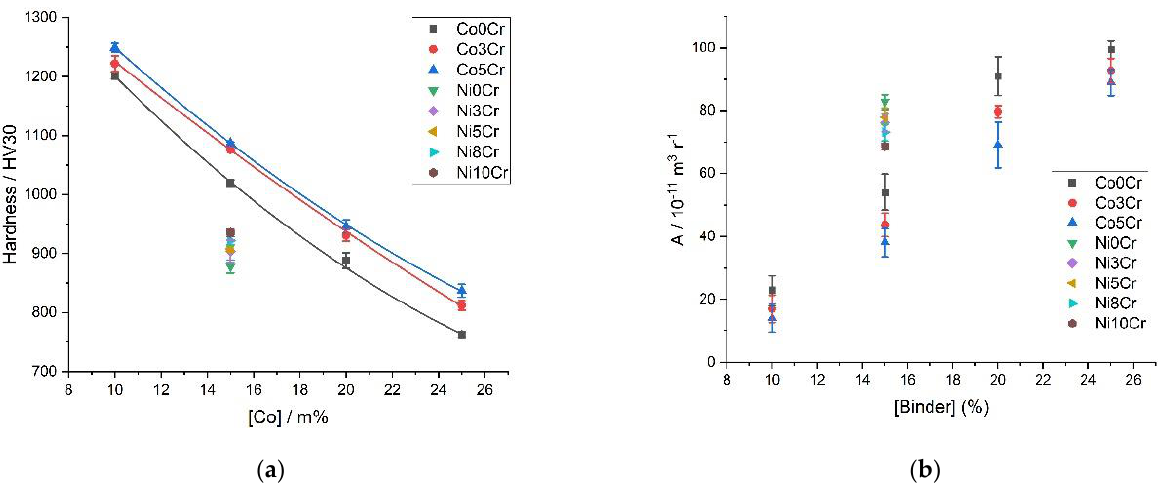
Figure 5. Dependence of hardness ( a ) and abrasion behaviour (ASTM B611) ( b ) on the amount of main component of the binder and of Cr (for details on samples, see Table 2).